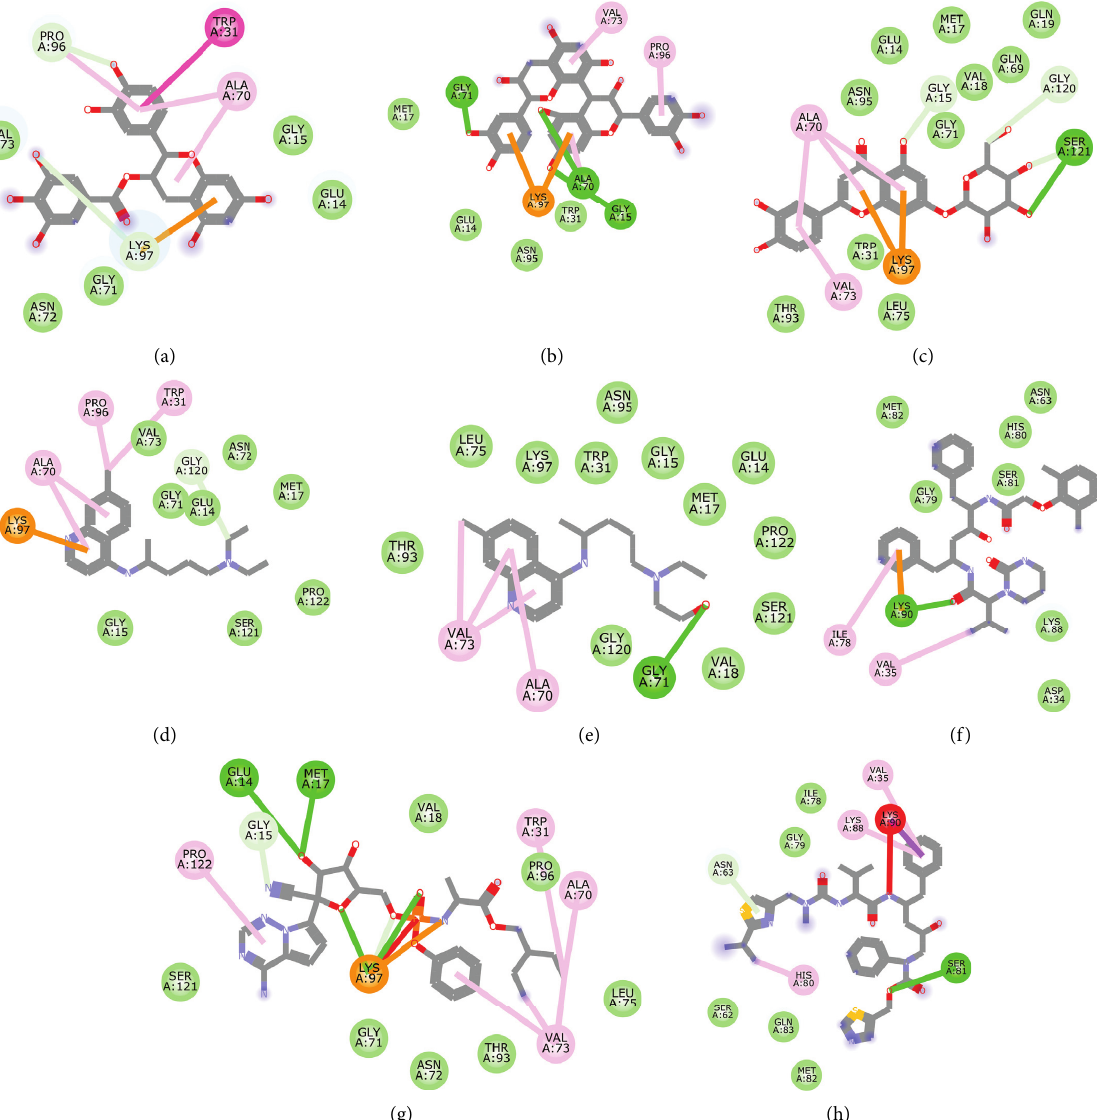
Figure 3: 2D representation of (a) 3-galloylcatechin, (b) proanthocyanidin B1, (c) luteolin 7-galactoside, (d) chloroquine, (e) hydrox- ychloroquine, (f) lopinavir, (g) remdesivir, and (h) ritonavir in the binding pocket of 3CLpro. Hydrogen, carbon-hydrogen, and unfavourable and π bonds are depicted as green, light blue, red, and any other coloured (purple, magenta, orange, and pink) lines, while Van der Waal interactions appear as light green